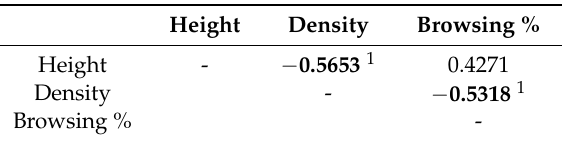
Figure 2. Ungulate density and browsing in study plots 1–5. Table 1. Correlation matrix for woody plants height, density, and intensity of browsing damage (% of damaged woody plants).